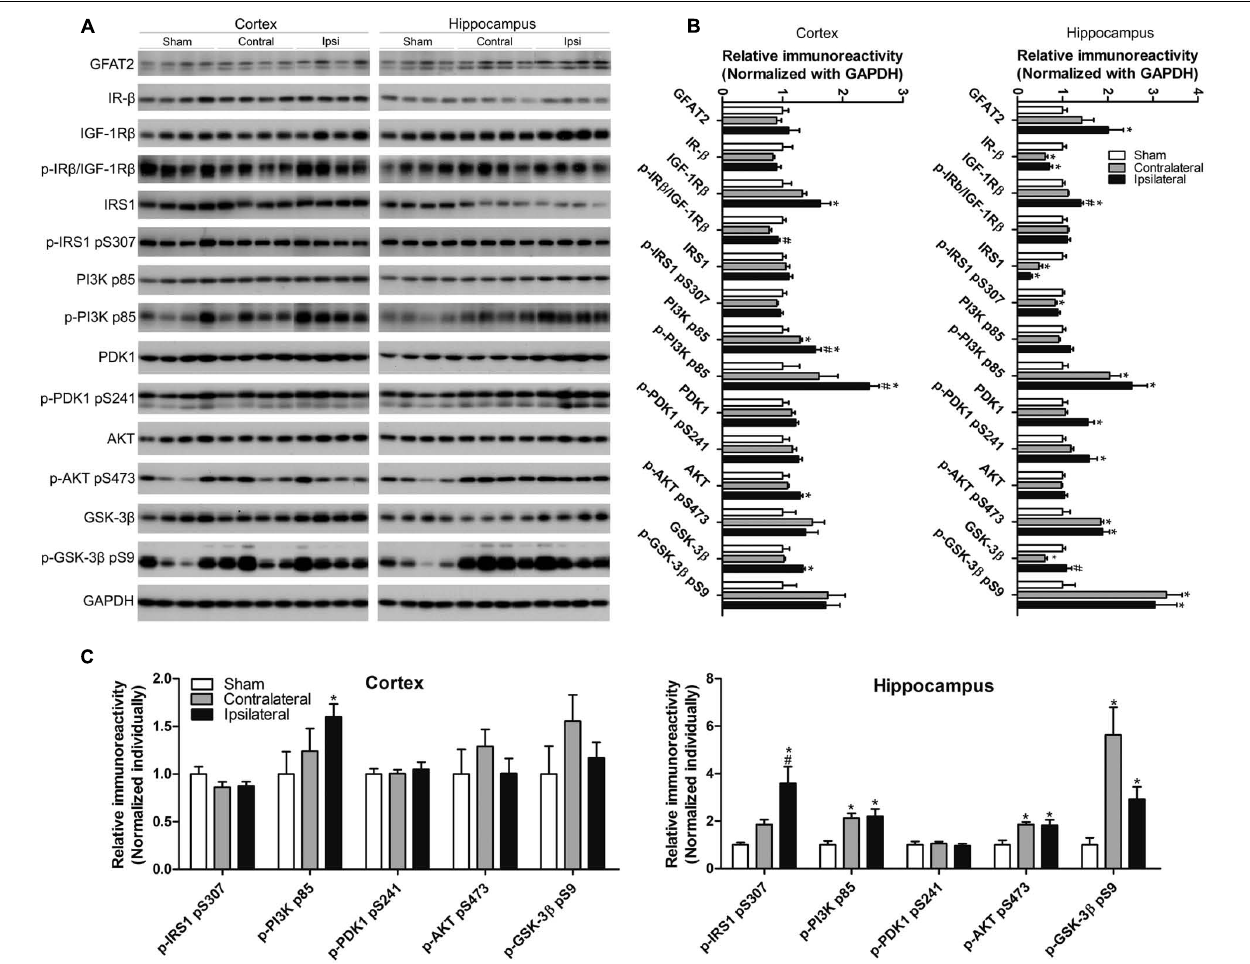
FIGURE 6 | Effects of CCH on the GFAT2 and the insulin signaling pathway. Homogenates of the cortices and hippocampi of mice 2.5 months after sham or UCCAO surgery were analyzed byWestern blots developed with the indicated antibodies (A) .The blots were then quantified